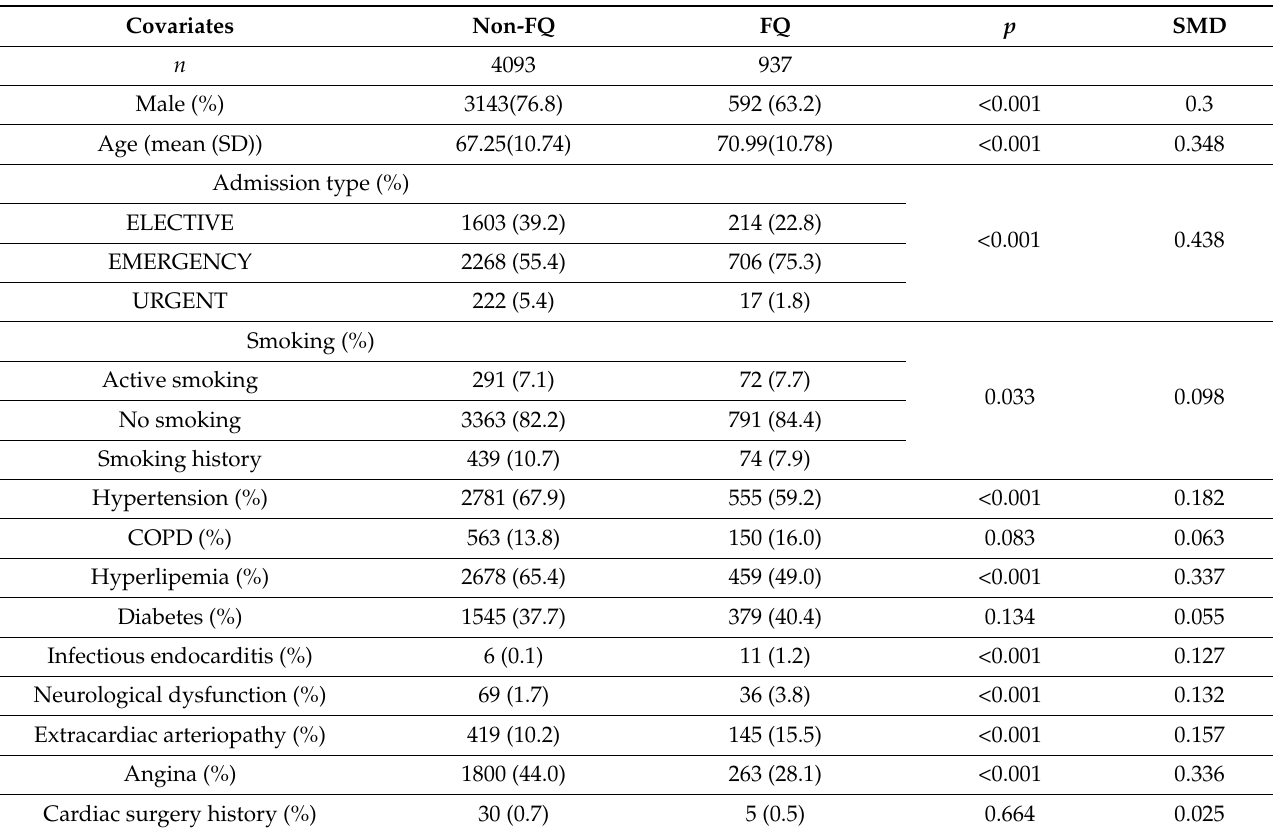
Table 1. Baseline data of extracted patients from MIMICIII database. COPD: chronic obstructive pulmonary disease; LVEF: left ventricular ejection